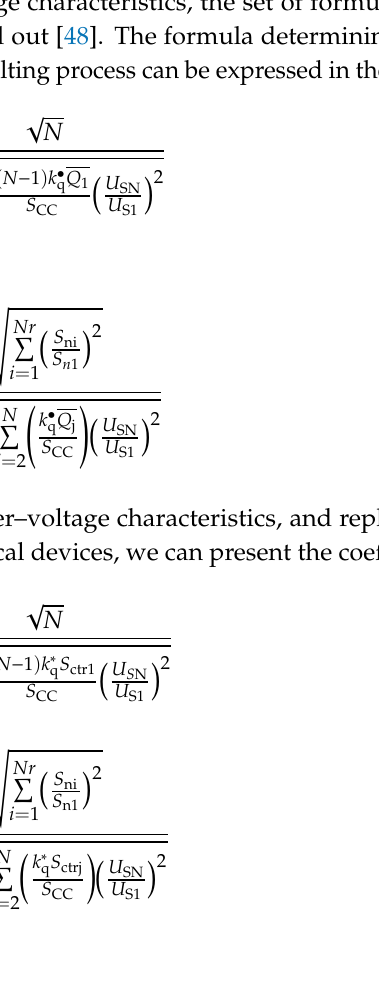
Figure 15. Voltage fluctuations in the steel network supplying the steelworks with different numbers of arc furnaces, ( a ) RMS value changes, ( b ) changes in the amplitude of voltage fluctuations.